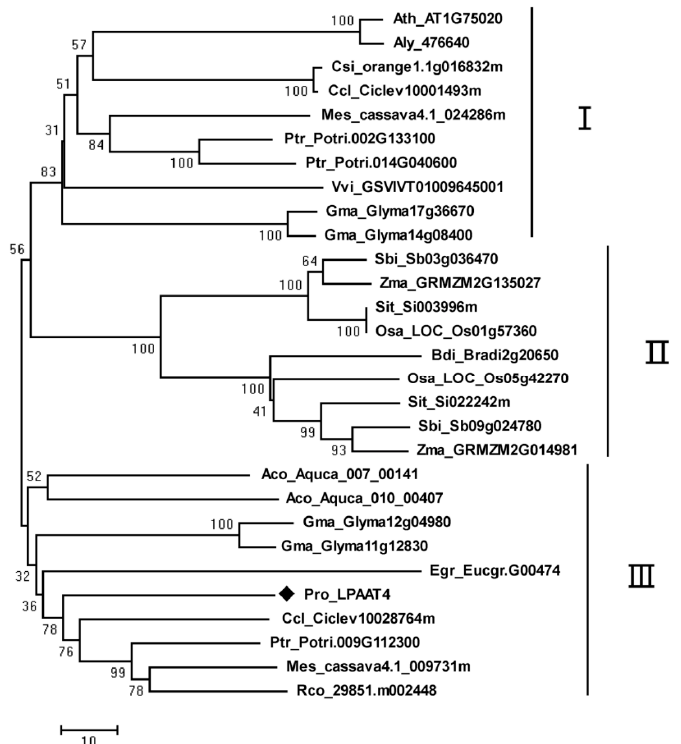
Figure 3. Phylogenetic comparison of the LPAAT4 proteins. Plant species included in the phylogenetic tree are Manihot esculenta (Mes), Ricinus communis (Rco), Populus trichocarpa (Ptr), Glycine max (Gma), Arabidopsis thaliana (Ath), Arabidopsis lyrata (Aly), Citrus sinensis (Csi), Citrus clementina (Ccl), Eucalyptus grandis (Egr), Vitis vinifera (Vvi), Aquilegia coerulea Goldsmithn (Aco), Sorghum bicolor (Sbi), Zea mays (Zma), Setaria italica (Sit), Oryza sativa (Osa), and Brachypodium distachyon (Bdi) . PrLPAAT4 is highlighted with a rhombus. The neighbor-joining method with MEGA software (version 5.1, Tokyo Metropolitan University, Hachioji, Tokyo, Japan) was used to construct the phylogenic tree. Boot-strap values as a percentage of 1000 replicates are indicated at corresponding branch nodes. Scale bar represents the number of amino acid substitutions per